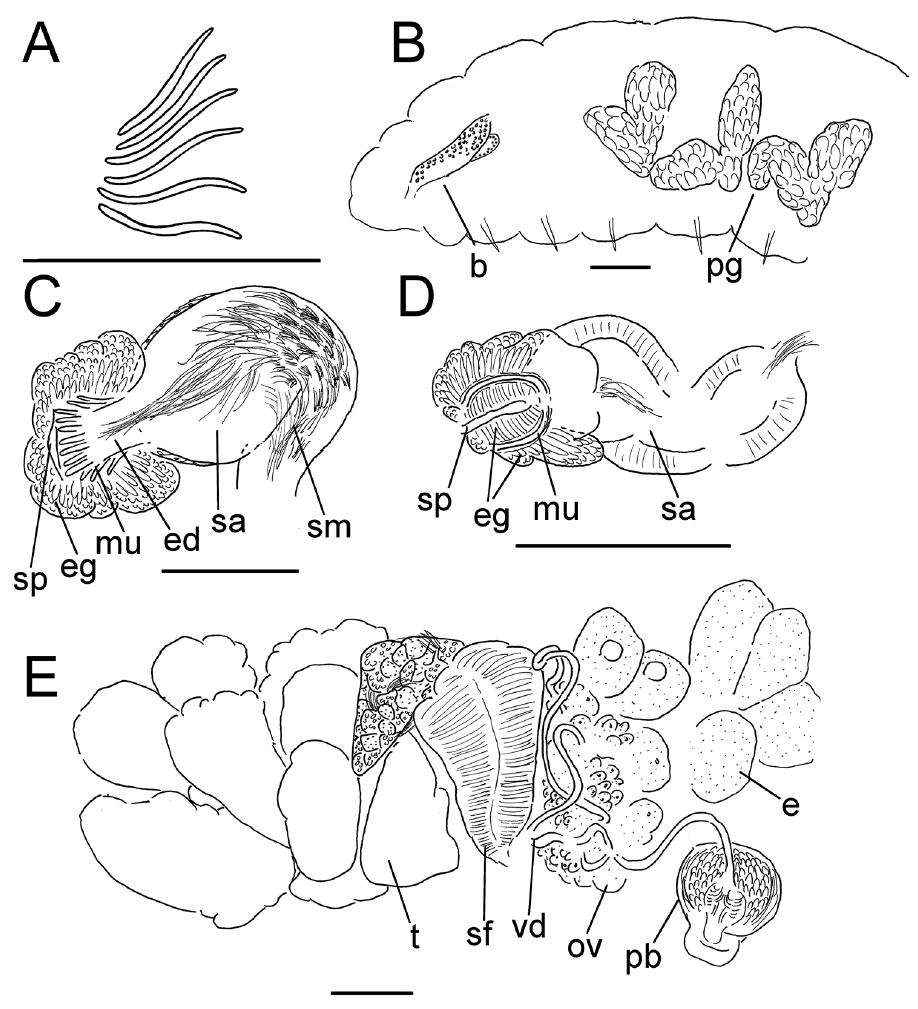
Figure 12. Lumbricillus rubidus . A Chaetal bundle B Anterior body C , D Spermatheca. E Other geni- talia. Abbreviations under general notes. Scale bars: 100